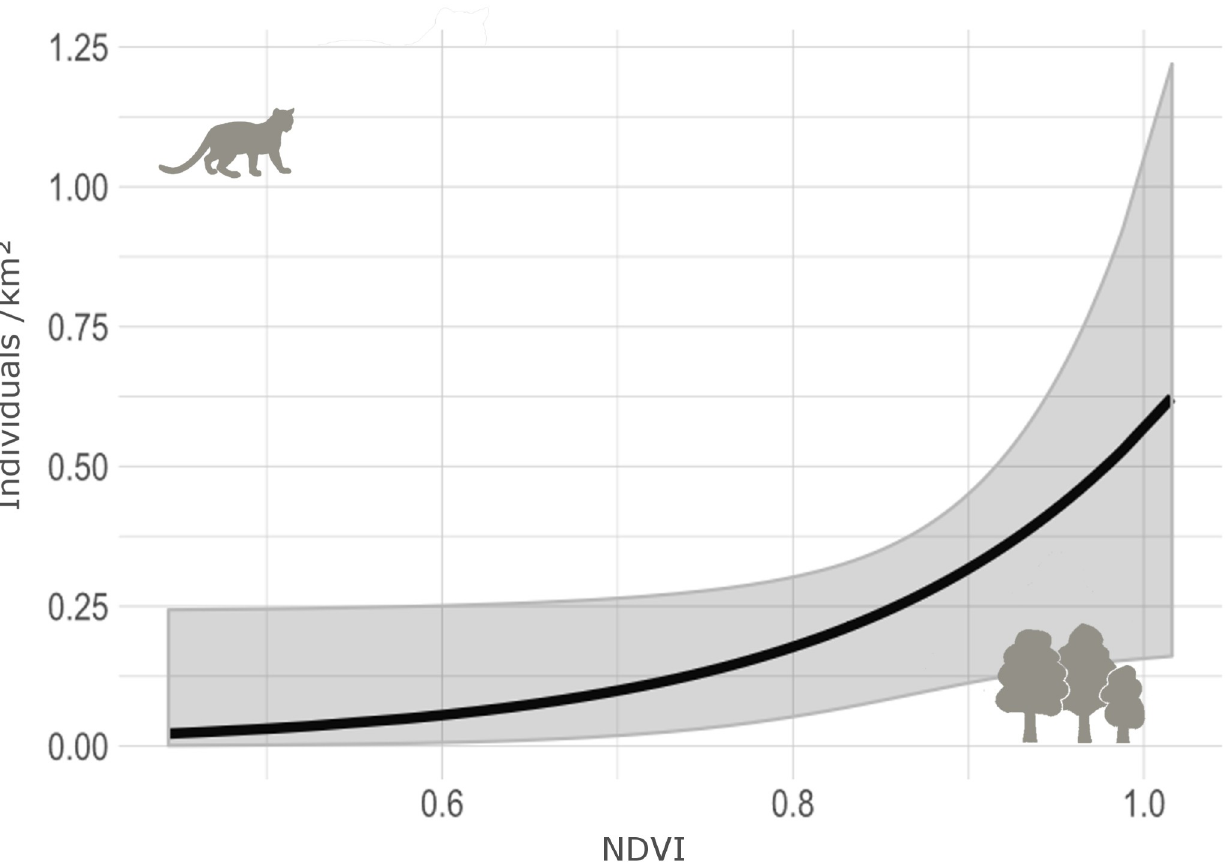
Fig 5. Effect of the vegetation cover (NDVI) on margay’s density estimates (ind/km 2 ) in the sampled areas.